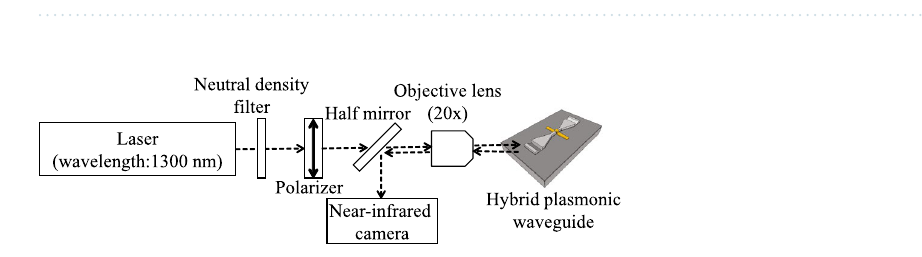
Figure 7. Fabrication processes of the hybrid plasmonic waveguide.